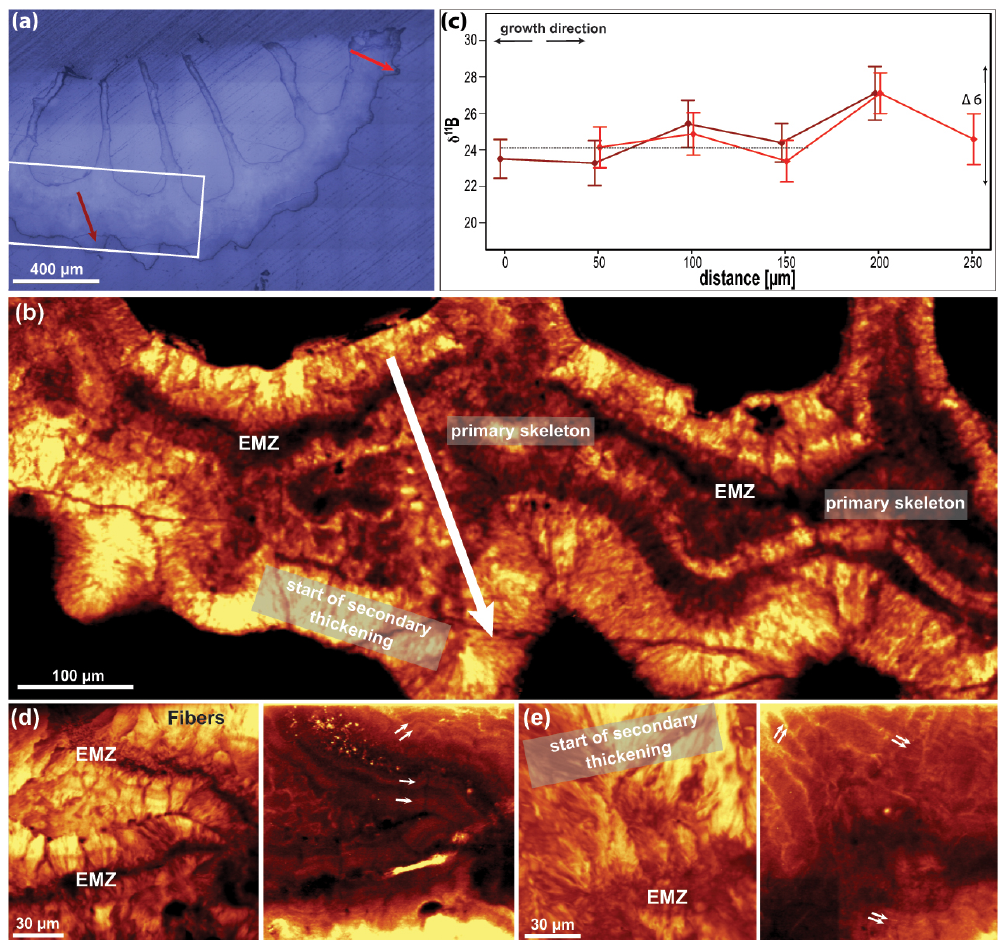
Figure 5. New branch of Lophelia pertusa cut above the staining line in transversal plane and prepared for Raman mapping and SIMS analysis. (a) Microscopic image displays the location of the Raman map and the SIMS transects. (b) Raman map of the intensity distribution of the main aragonite peak (symmetric stretch, 1085cm − 1 ) reveals the early mineralization zone (EMZ), the primary skeleton and the start of secondary thickening. (c) δ 11 B measured from inside to the outer coral skeletal rim (transect #6,7). (d, e) Raman maps of aragonite fibre orientation (left map) and fluorescence (right map) within the primary skeleton with early mineralization zone (EMZ) and with starting of the secondary thickening (e) . The arrows in (d, e) mark skeletal organic matrix